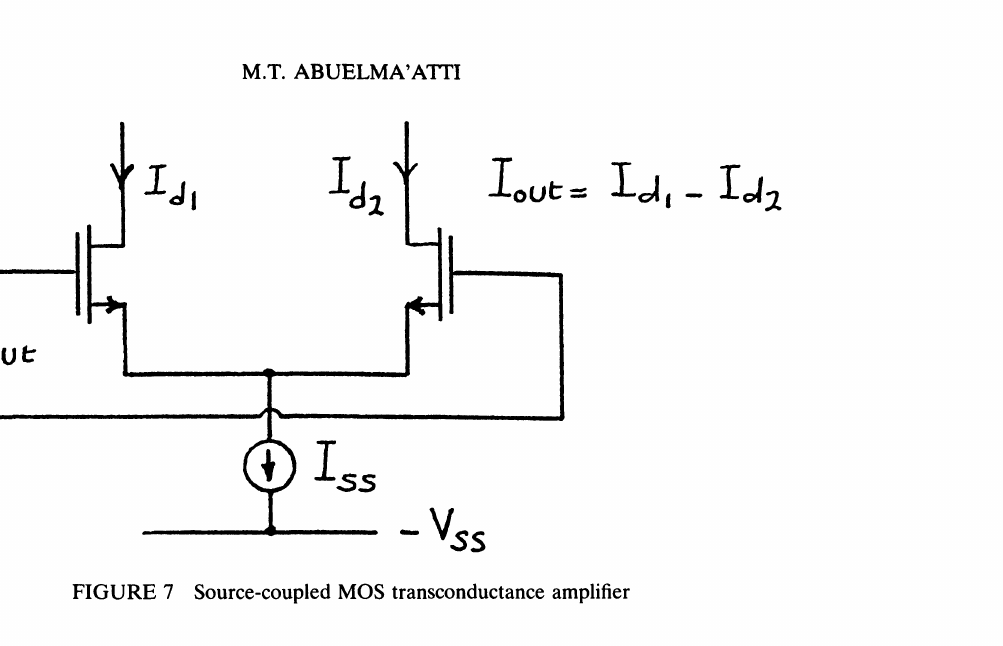
FIGURE 7 Source-coupled MOS transconductance